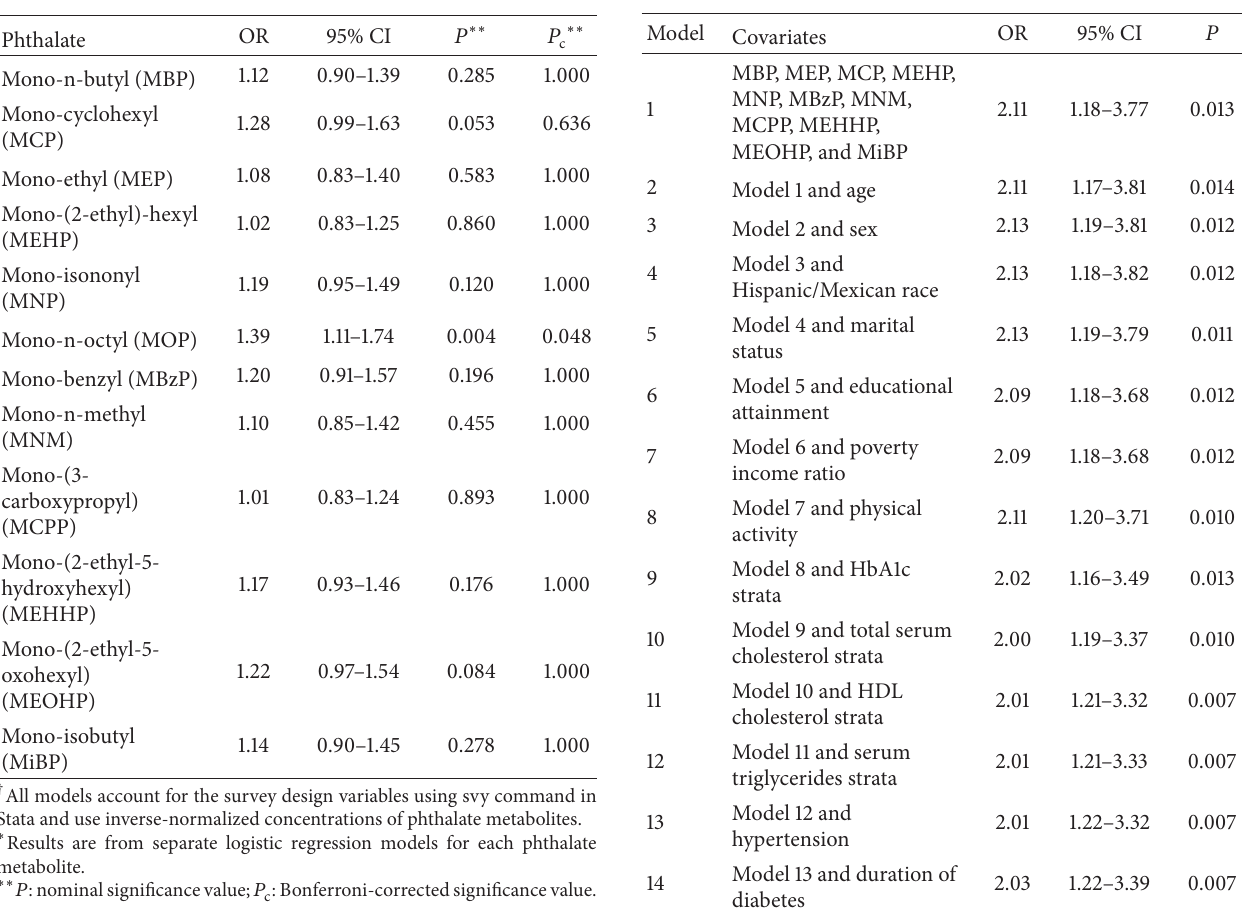
Table 2: Univariate association of urinary phthalate metabolites with self-reported eye affliction/retinopathy in participants with diabetes, NHANES 2001–2010 †,∗ .